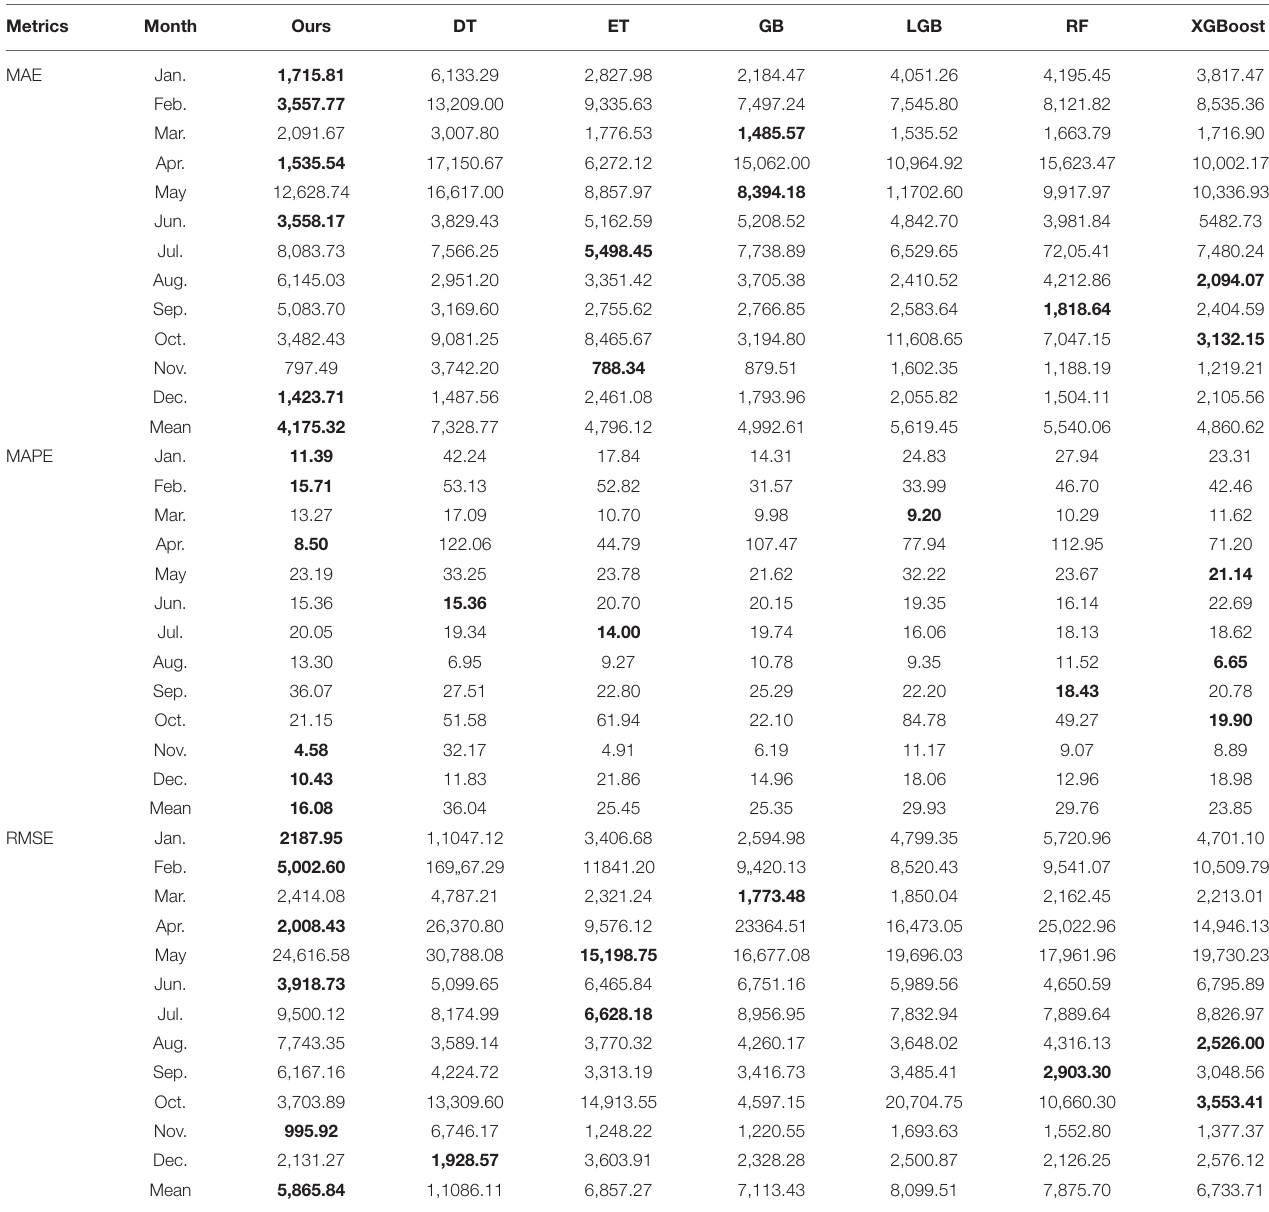
TABLE 3 | Forecasting results in 2019.